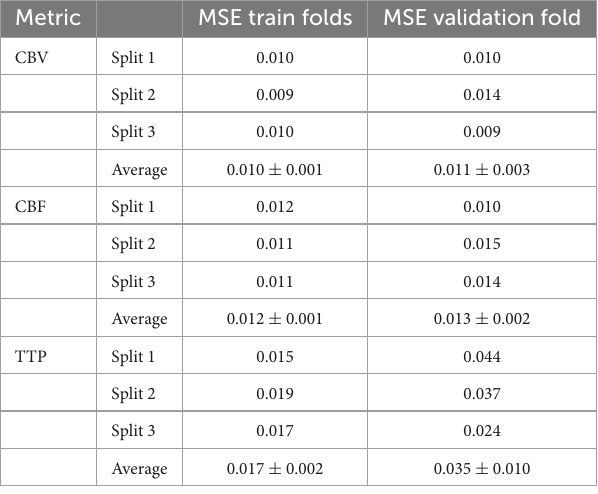
TABLE 1 Threefold cross-validation results for CBV, CBF, and